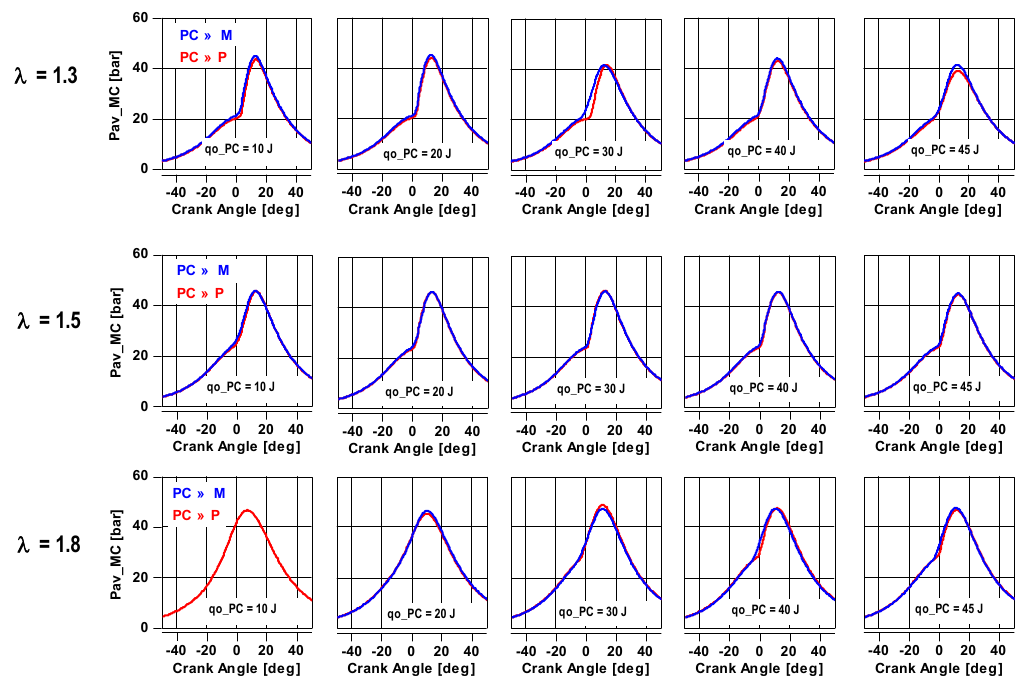
Figure 4. In-cylinder (main chamber) pressure curves Pav_MC averaged from 100 cycles of combustion pressure in the cylinder when the prechamber was fueled with methane or propane (methane was always supplied to the main chamber via injector placed in intake duct).